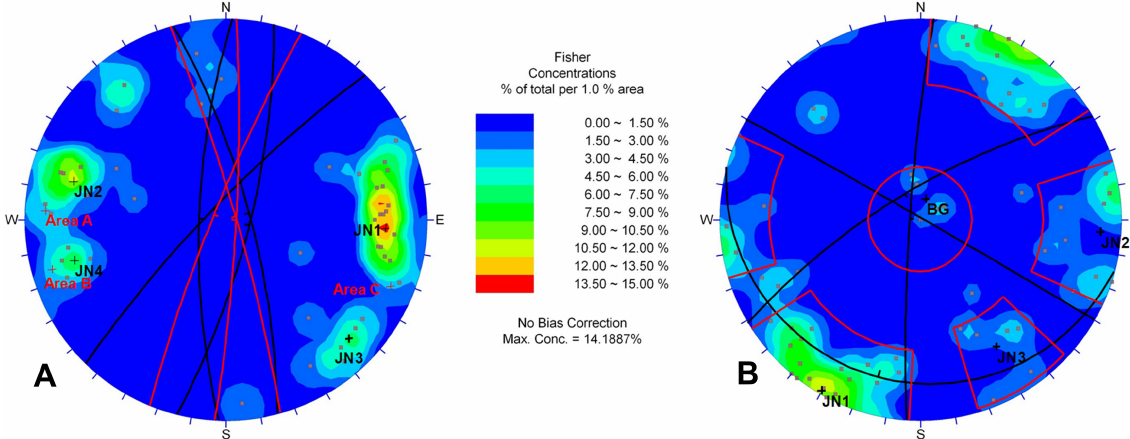
Fig. 8. Discontinuity poles, contour lines and modal planes of the main discontinuity sets collected at Mdina (A) and Citadel (B) . The mean buried rock-slope orientation of the Mdina areas investigated is also reported (red major